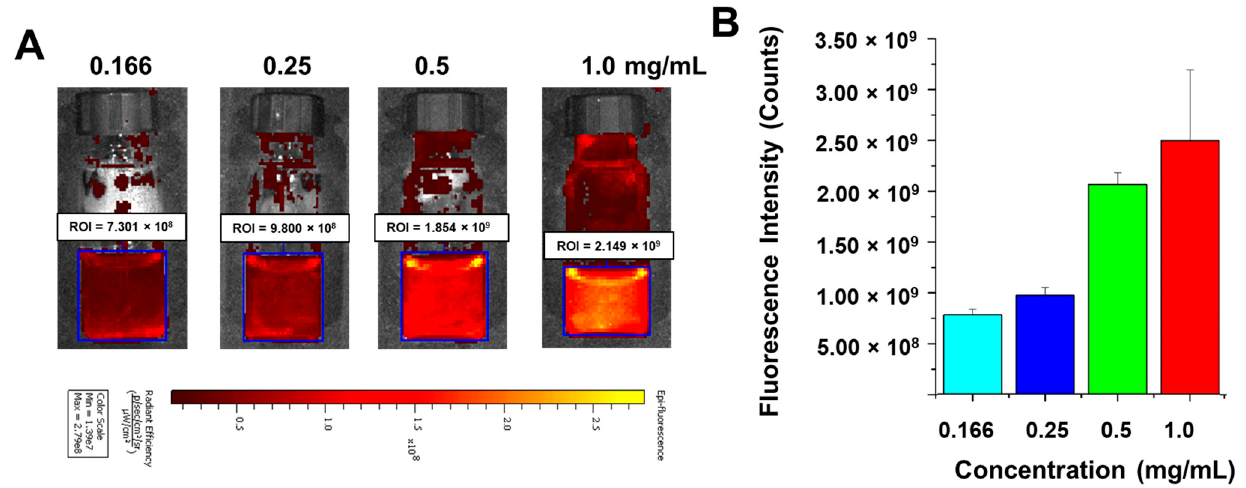
Figure 4. Chlorophyll measurement in agarose gels. Here, 2.5% agarose was utilized for phantom gel preparation with different dilutions of bay leaf extracted chlorophyll. ( A ) Gels were imaged using IVIS Imaging System at 600/710 nm. ( B ) Quantitation of the fluorescence measurement. Data represent the average of three different experiments.